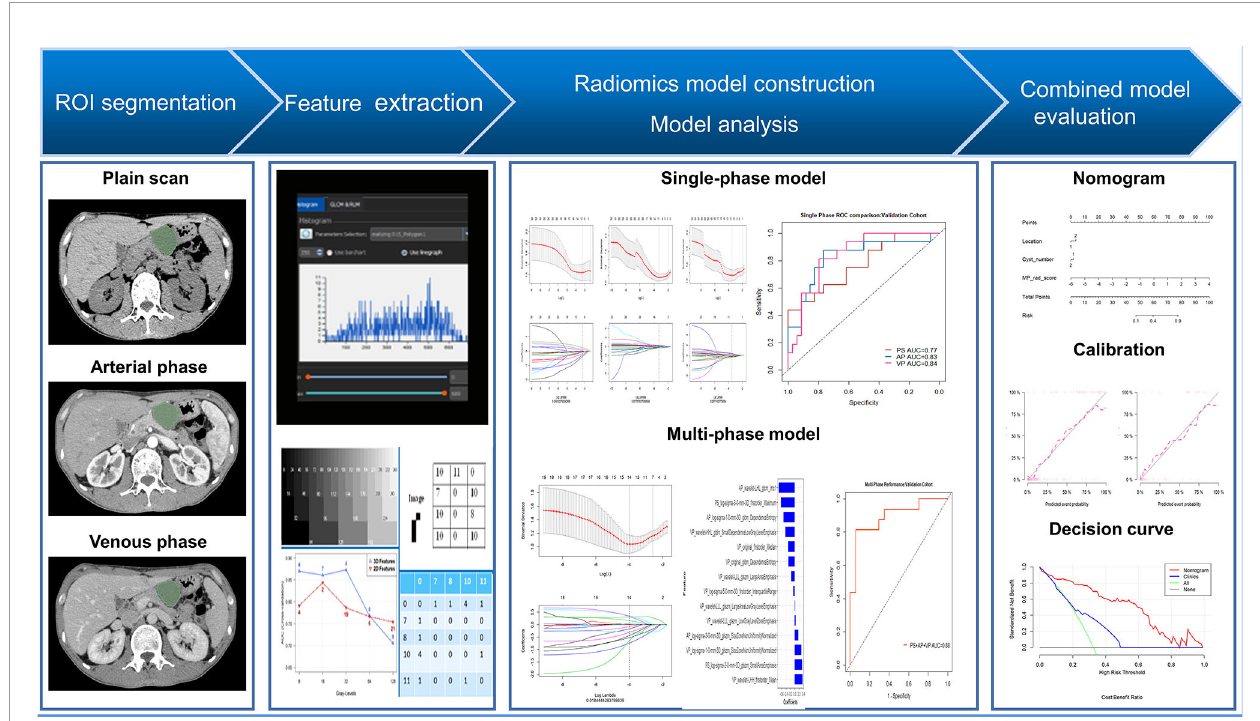
FIGURE 1 | Radiomics work fl